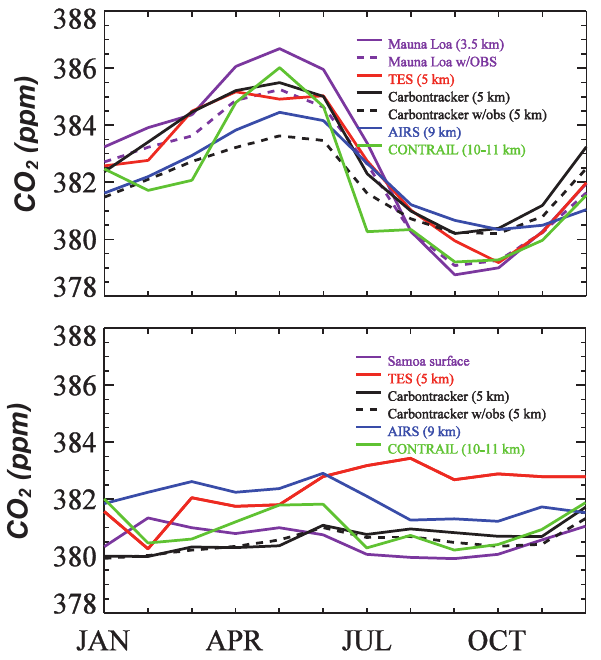
Fig. 11. Monthly averaged CO 2 July 2005 to July 2008 in the Northern Hemisphere (top panel) and Southern Hemisphere (bot- tom panel). In the Northern Hemisphere, the agreement is gen- erally within 2ppm for all datasets, with Mauna Loa showing the most seasonal variability and TES versus Mauna Loa with the TES observation operator applied showing the best agreement. In the Southern Hemisphere, TES values are ∼ 2ppm high compared to Samoa and CONTRAIL in the second half of the year which is dis- cussed in the text.